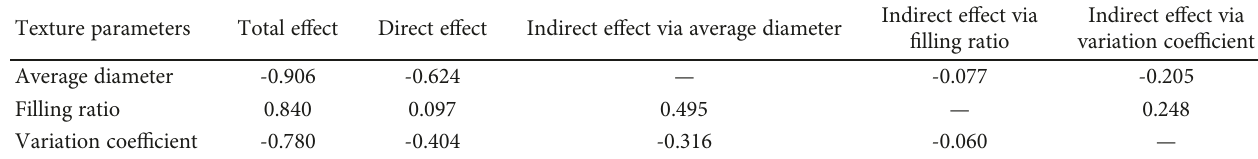
Table 5: The direct and indirect e ff ects of texture parameters on block